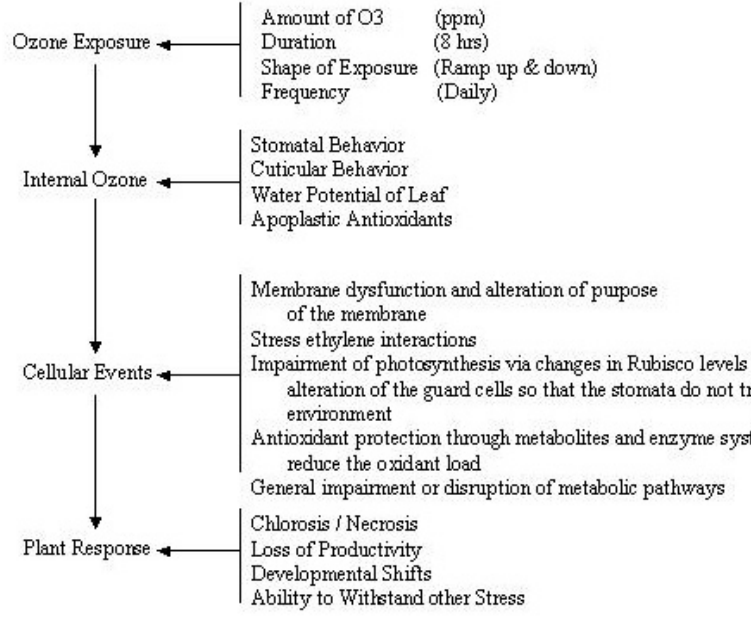
FIGURE 1. Sequence of ozone interaction with plant tissues. A shortened version of the important events with ozone interacting with leaf tissue. Some of the events shown here are just touched on, while others are discussed in the text at length. This is a short roadmap of important